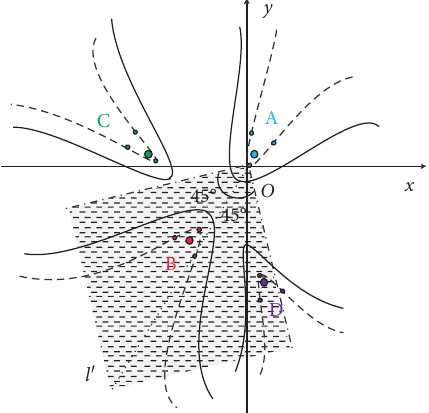
Figure 7: Baseline endpoint matching